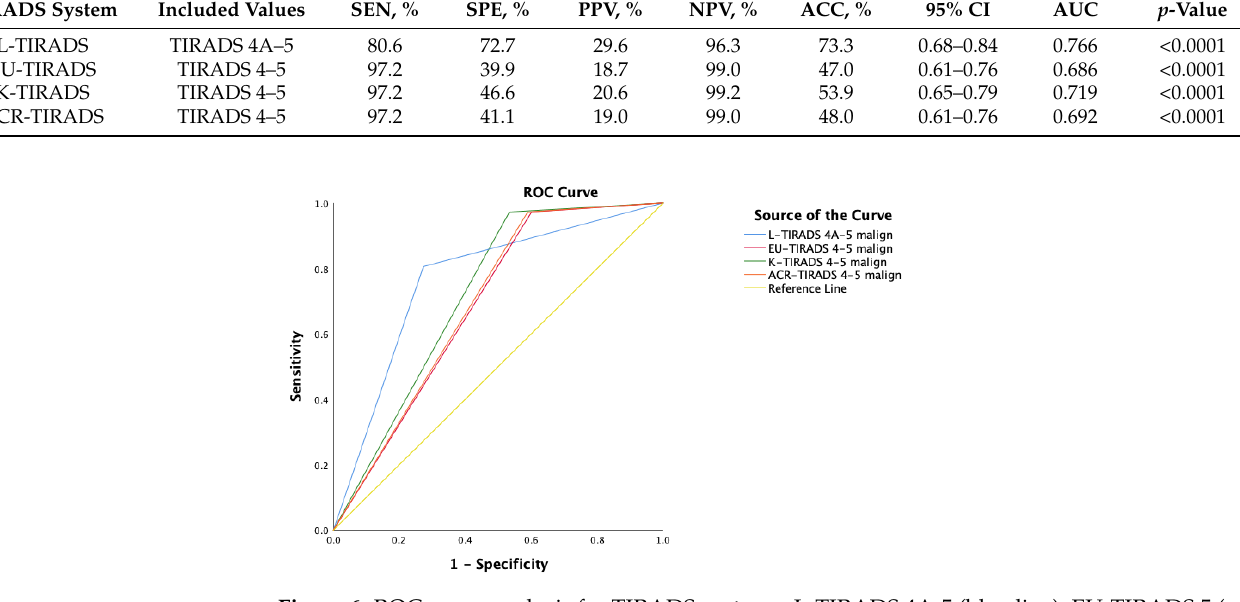
Figure 6. ROC curve analysis for TIRADS systems. L-TIRADS 4A-5 (blue line), EU-TIRADS 5 (red line), K-TIRADS 5 (green line), ACR-TIRADS 5 (orange line), reference line (yellow line). In the comparison between L-TIRADS and EU-TIRADS, K-TIRADS, and ACR TI- RADS among the 126 thyroid nodules classified as TIRADS 5 by the EU-TIRADS, 23 were downgraded to 4C, 29 were downgraded to 4B, 57 were downgraded to 4A, 4 were down- graded to TIRADS 3, and 13 were categorized into the same TIRADS category. Among the 82 thyroid nodules classified as TIRADS 4 by the EU-TIRADS, 74 were downgraded to TI- RADS 3 by L-TIRADS, and 8 were categorized into the same TIRADS category (Table 8). Table 8. Comparison between the L -TIRADS and EU-TIRADS classifications. L-TIRADS